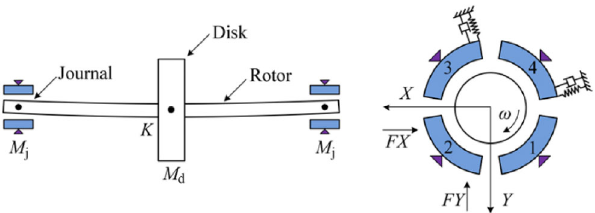
Fig. 1 Model of a Jeffcott rotor supported by two four-pad TPJBs.